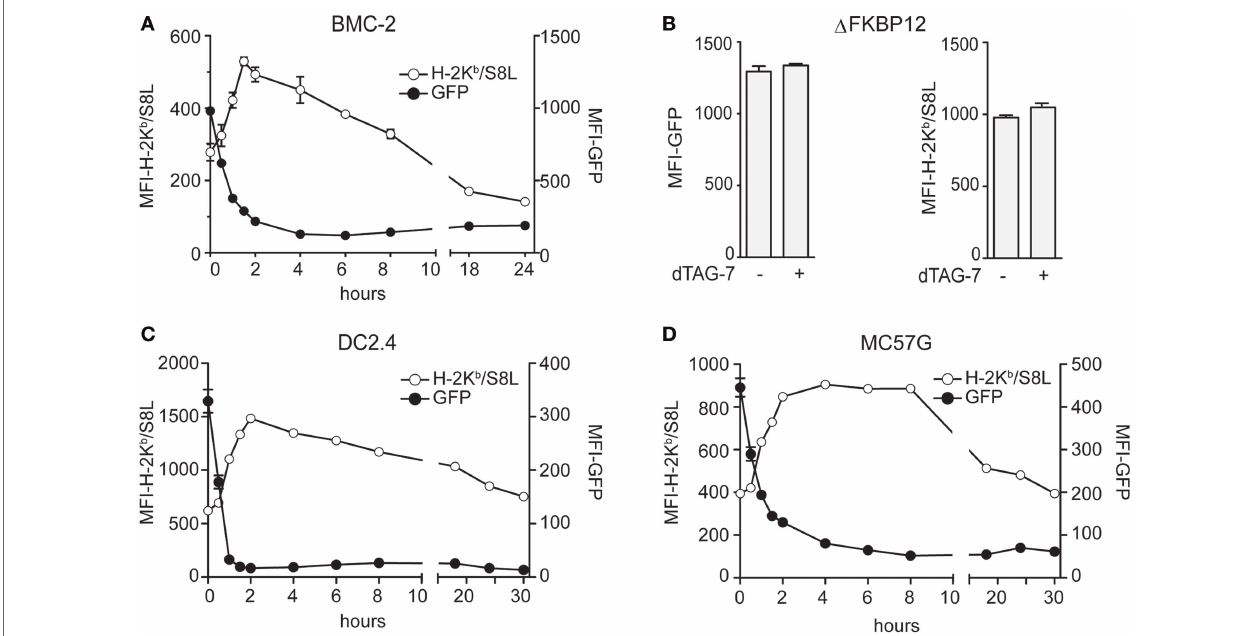
FigUre 2 | Degradation tag (dTAG)-7-induced antigen degradation increases its MHC class I presentation. (a) GFP-S8L-F12-expressing BMC-2 cells were treated with 1 µM dTAG-7 for indicated times. GFP-specific fluorescence (MFI-GFP) and MHC class I presentation of antigen-derived S8L (MFI-H-2K b /S8L) was detected by flow cytometry. MFI, mean fluorescence intensity. (B) BMC-2 cells expressing Δ FKBP12 were treated for 2 h with 1 µM dTAG-7 or left untreated as control and MFI-GFP as well as MFI-H-2K b /S8L were measured by flow cytometry as described above. (c,D) GFP-S8L-F12-expressing DC2.4 (c) and MC57G (D) cells were treated and analyzed as described in (a) . All experiments were performed in triplicates and results are shown as mean ± SEM. Representative results from three independent experiments are